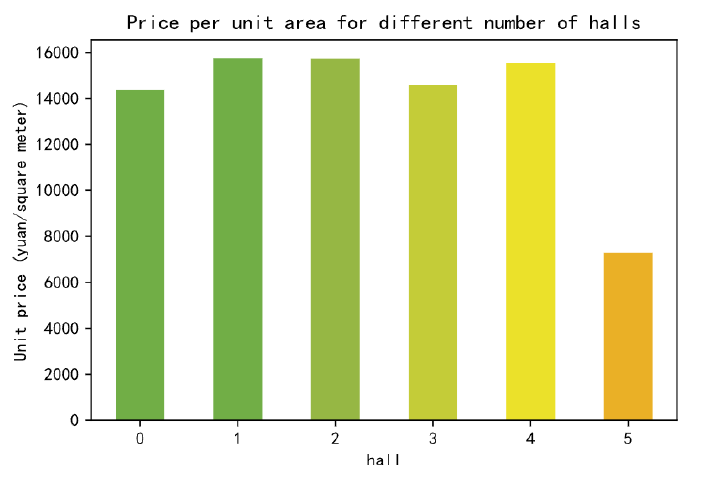
Fig. 4 Price per unit area of various number of halls